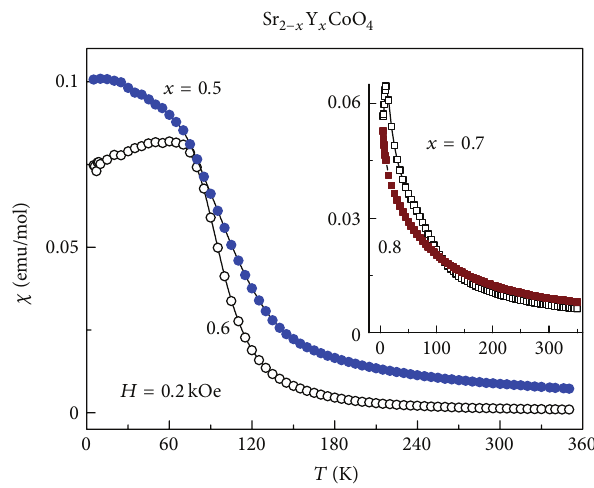
Figure 1: The main frame represents the field cooled (FC) suscep- tibility 𝜒(𝑇) of Sr 1−𝑥 Y 𝑥 CoO 4 ( 𝑥 = 0.50 and 0.60) at 𝐻 = 0.20 kOe. The inset shows the FC- 𝜒(𝑇) of the samples of 𝑥 = 0.70 and 0.80 at 𝐻 = 0.20